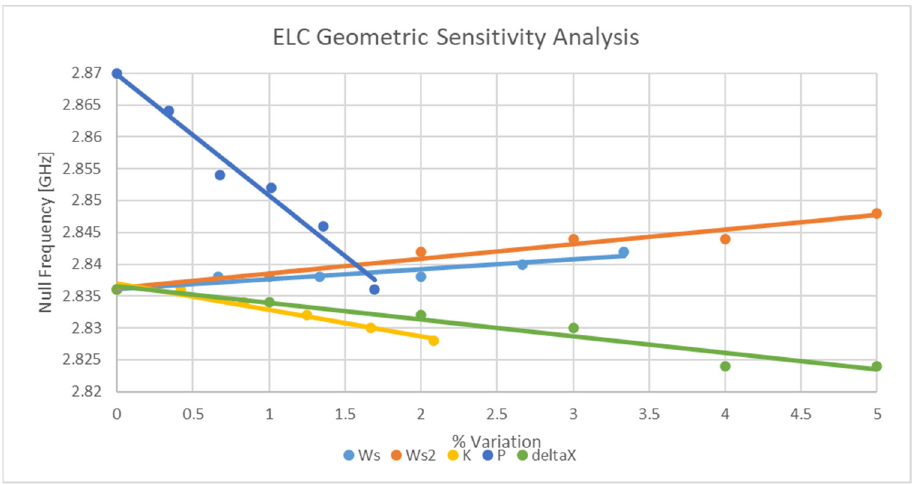
Figure 14. Sensitivity analysis of resonator geometry.